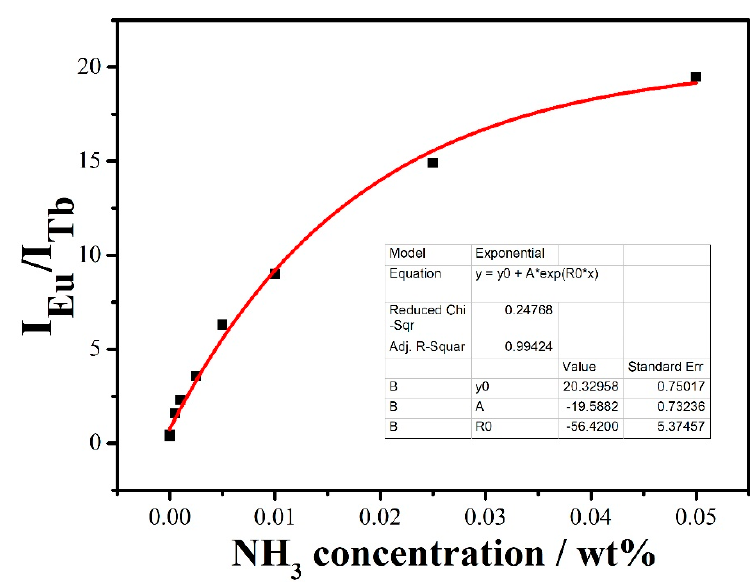
Figure 4. The variation curve of I Eu /I Tb versus the concentration of aqueous ammonia (c a ).